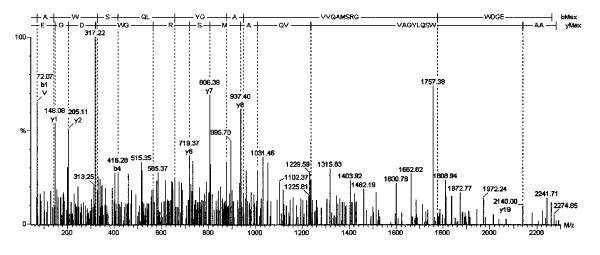
The tandem mass spectrum is shown for the neuroglobin amino acid 131 to 151 peptide.